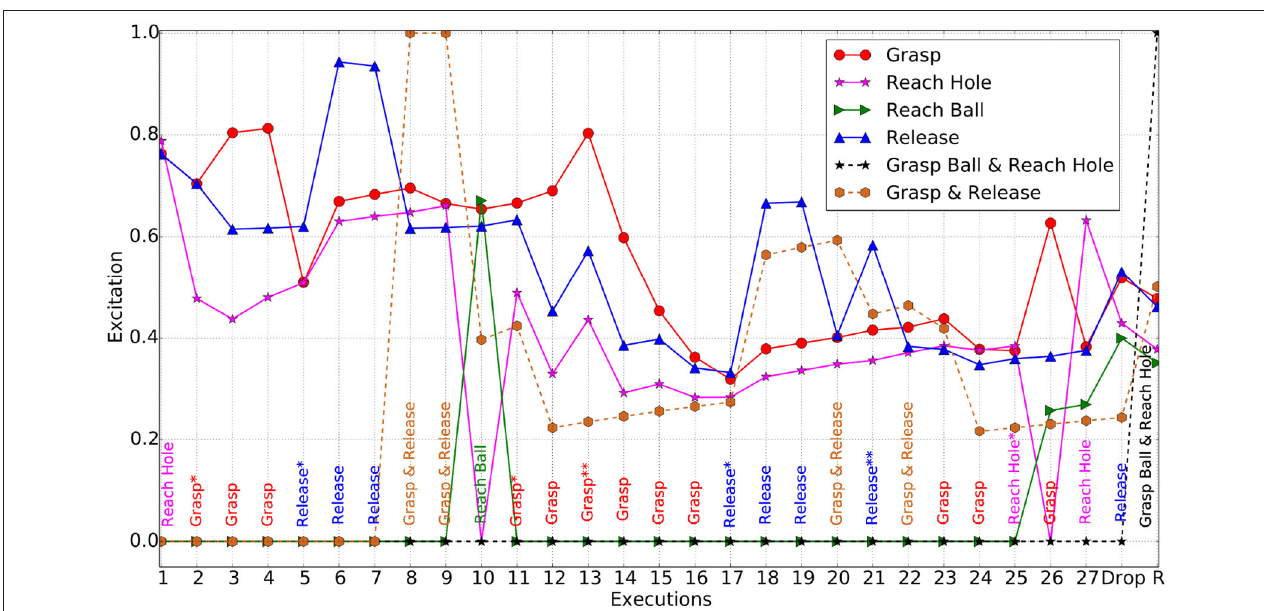
FIGURE 13 | Schema and Chain excitations for the iCub. The most excited schema/chain at each execution is specified across the bottom. Actions with asterisk(*) are the positions at which new schemas emerged and with asterisk(**) are the positions where generalized schema created. The chains contain emerged schemas only. Each solid lines shows excitation of the corresponding schema, whereas dashed line shows that of a chain.